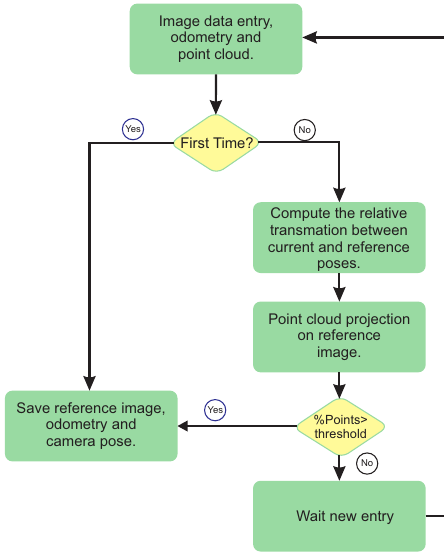
Figure 5. Cloud overlap analysis process.